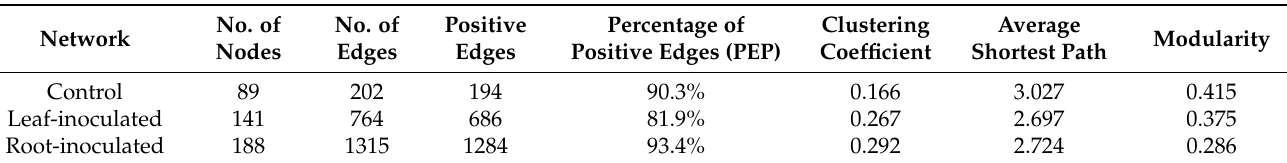
Table 1. Topological properties of control, leaf-inoculated, and root-inoculated plants co-occur- rence networks.